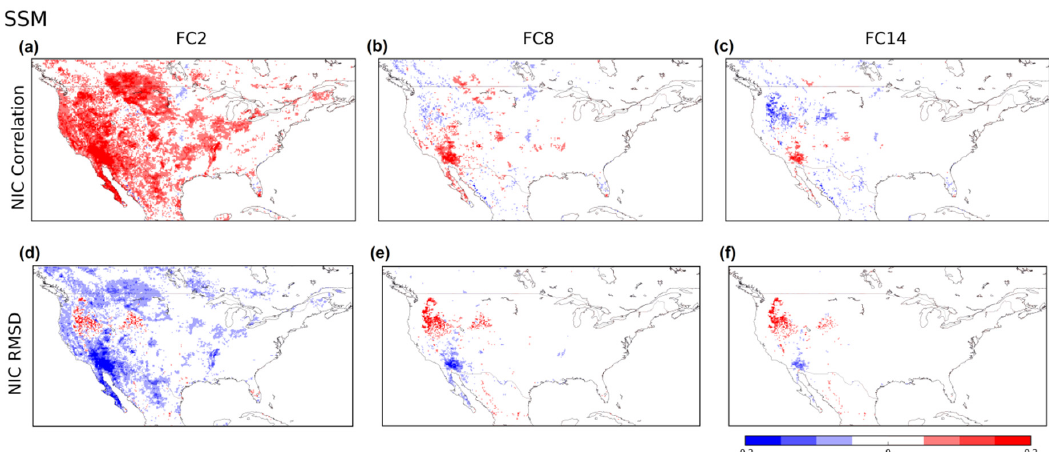
Figure 7. Spatial patterns of persistence of SEKF impact on simulated SSM as compared to CGLS SSM as forecast lead time increases. Upper row of maps shows NIC R values at FC2 ( a ), FC8 ( b ), and FC14 ( c ). Bottom row of maps ( d – f ) is the NIC RMSD values at the same forecast lead times. Note that red color for correlation is improvement from assimilation, whereas blue is improvement for RMSD.